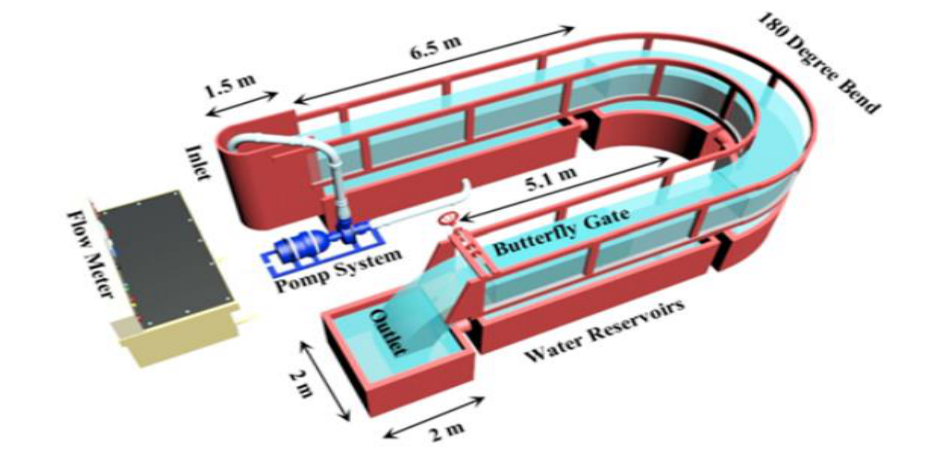
Figure 2. Laboratory flume employed by Vaghefi et al (2016)